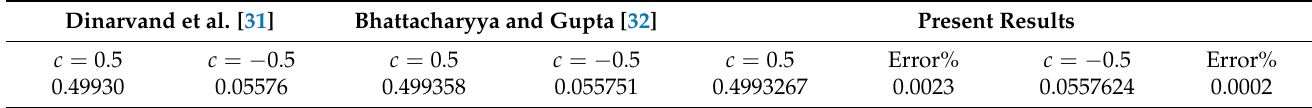
Table 3. Comparison of Re y 1/2 C fy in the y -axis coordinates with results from previously published work for the pure normal fluid when ϕ = 0 and λ = 0. Furthermore, the error% was calculated from